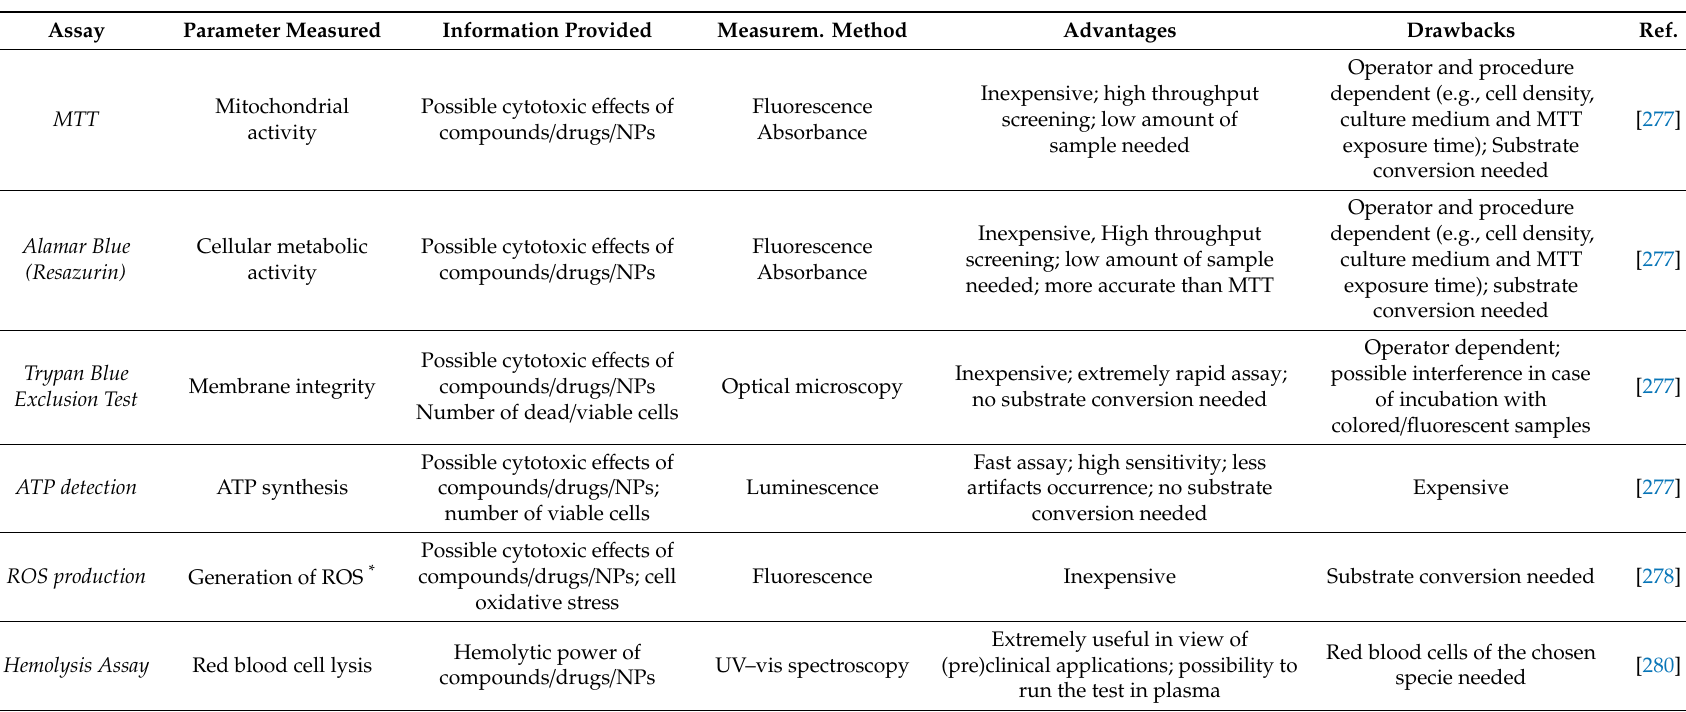
Table 3. Comparison between some of the most di ff use toxicity assays, useful to evaluate potential toxic e ff ects exerted by magnetic